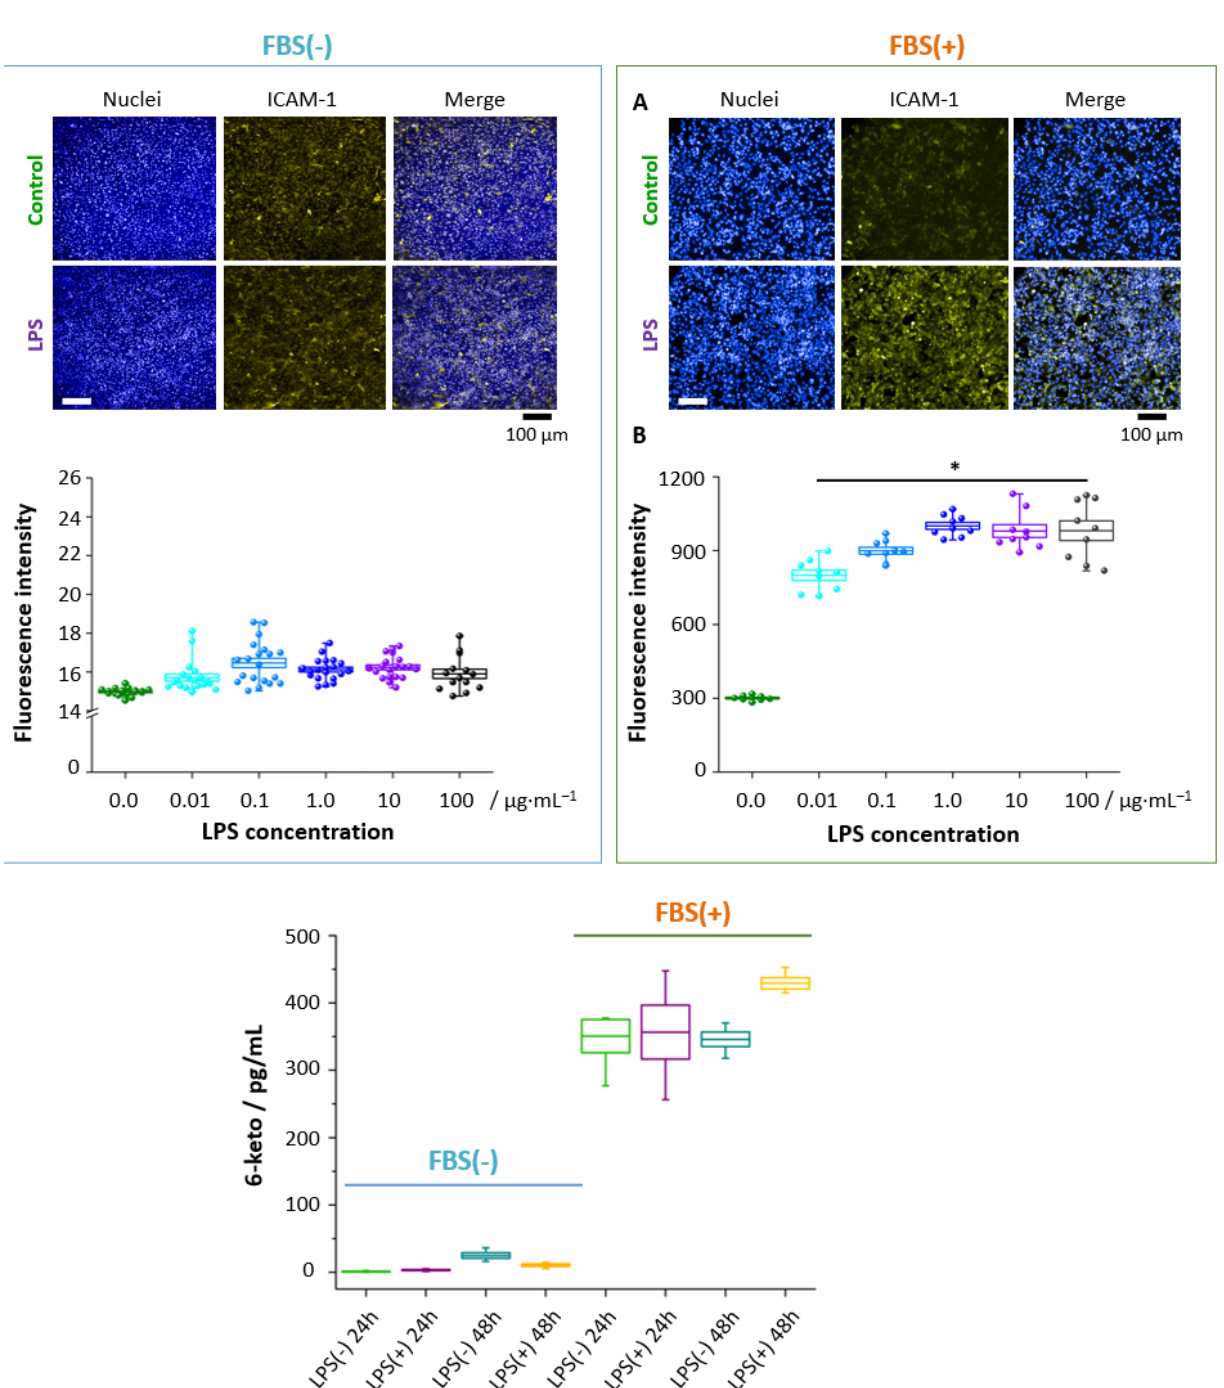
Figure 6. LPS-induced ICAM-1 expression and PGI 2 production in endothelial cells in the presence and absence of FBS. The staining of surface ICAM-1 molecules was performed for HMEC-1 after 24 h treatment with LPS E. Coli in different concentrations. Representative fluorescence images ( A ) showed the overexpression of ICAM-1 (fluorescence intensity of the fluorophore (R-phycoerythrin) fused to the ICAM-1 antibody, yellow areas, nuclei – blue areas) for LPS-treated cells (10 µ g · mL − 1 ) in comparison to control cells, combined with the analysis of fluorescence intensity ( B ). The concentration of 6-keto PGF1 α in effluent from HMEC-1 from control and LPS-stimulated (10 µ g · mL − 1 ) HMEC-1 with/without FBS supplementation ( C ). Values given as mean ± SEM are shown in box plots: mean (horizontal line), SEM (box), minimal and maximal values (whiskers). * p < 0.05.